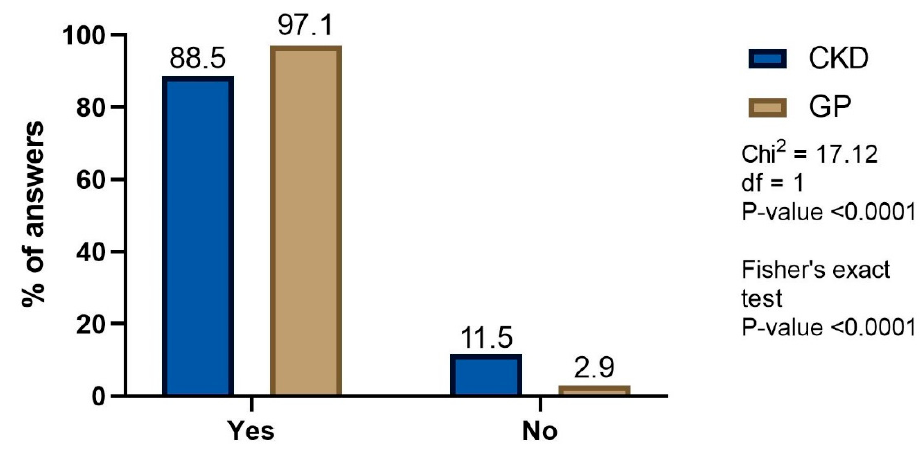
Figure 1. Proportion of CKD and GP patients using OTC NSAIDs or analgesics.